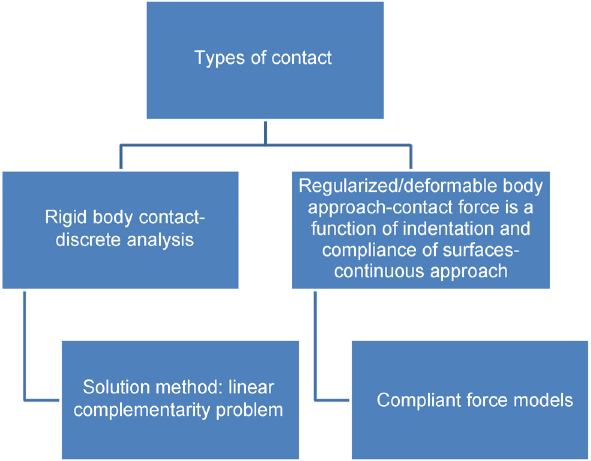
Fig. 14 Contact classification according to Machado et al.